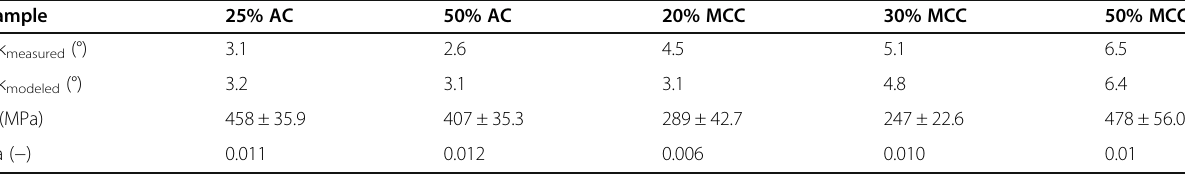
Table 1 Comparison of the measured curvature change Δκ measured of hygromorphs determined in a climate chamber and the modeled curvature change Δκ calculated by determination of elastic moduli (E) and hygrometric coefficients of linear expansion of the active layer ( α a )